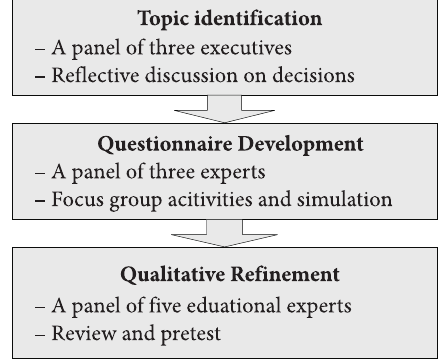
Fig. 1. Instrument